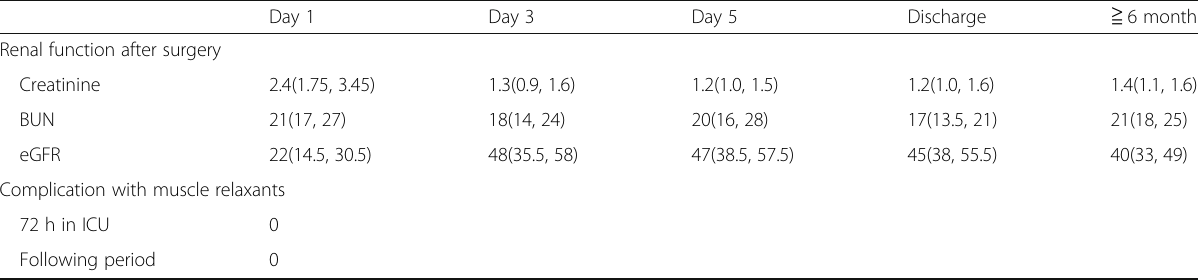
Table 2 Renal function and complication after